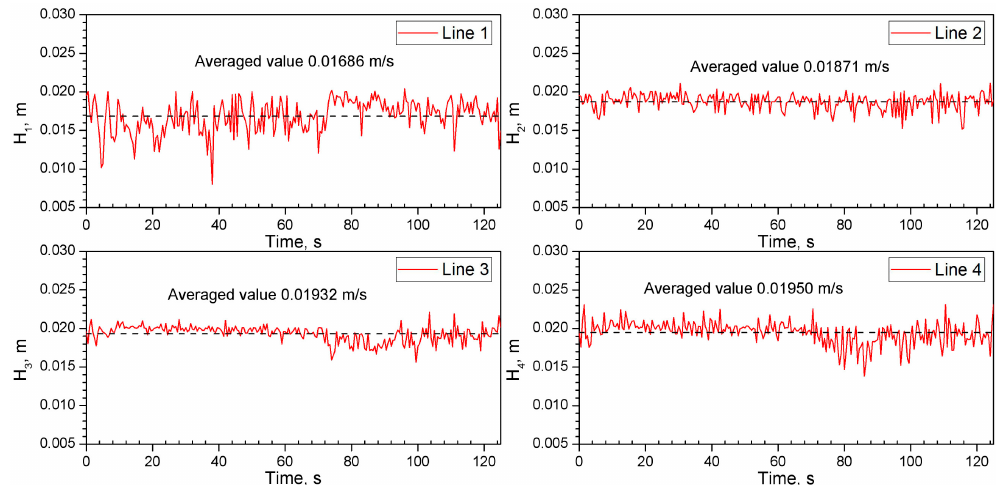
Figure 12. The time series of the air–slag interface fluctuations at four typical positions of ( a ) line 1, ( b ) line 2, ( c ) line 3, and ( d ) line 4.